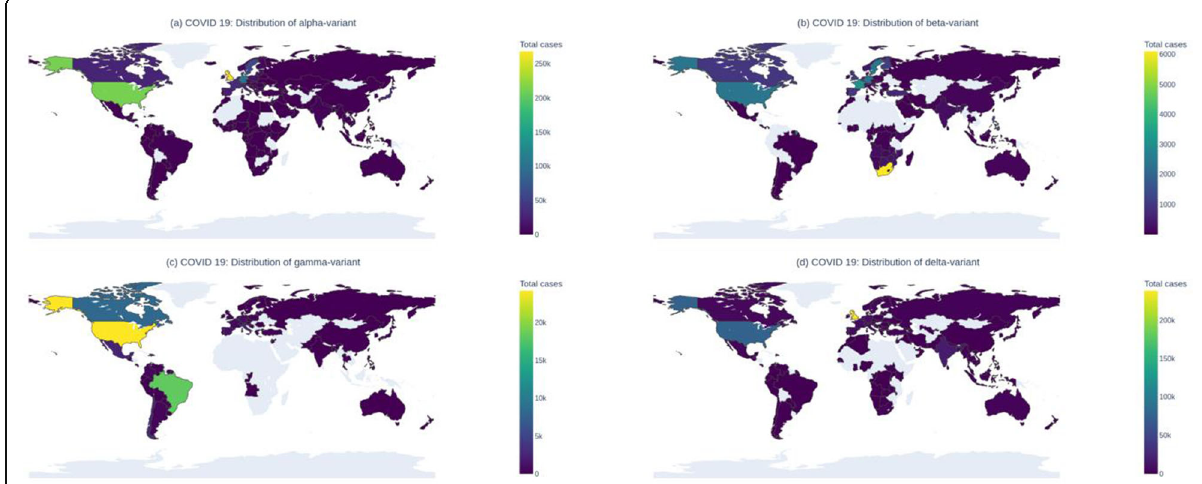
Fig. 1 Geographical distribution of major COVID-19 variants ( a — Alpha, b — Beta, c — Gamma, and d — Delta)